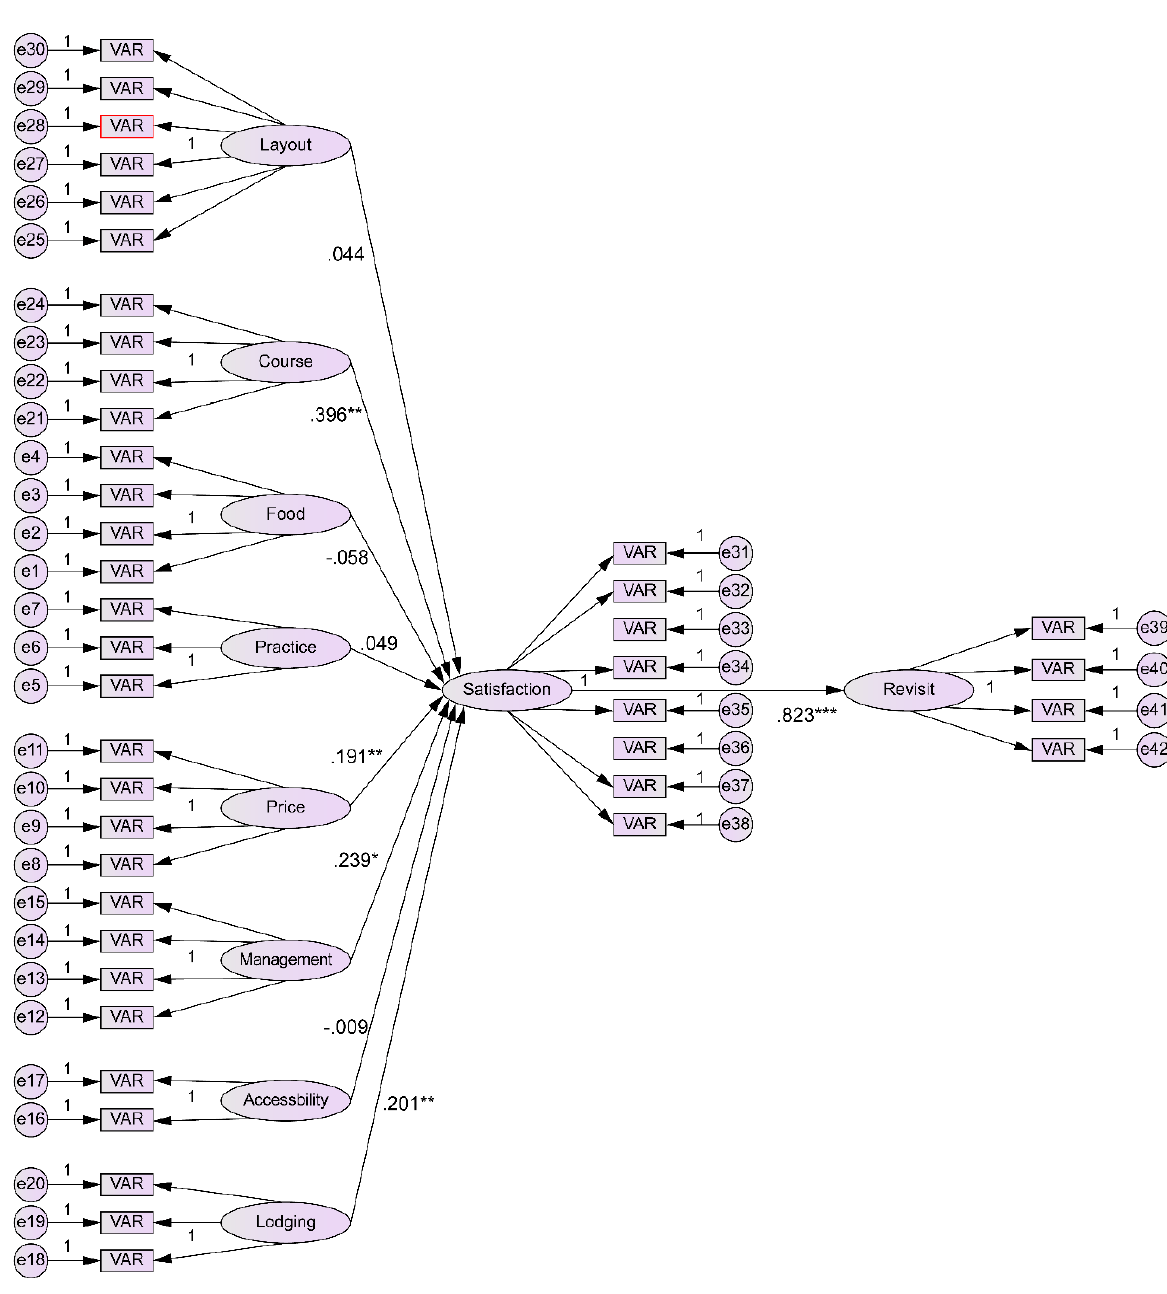
Figure 2. Validated model. Table 10. Results for H3.